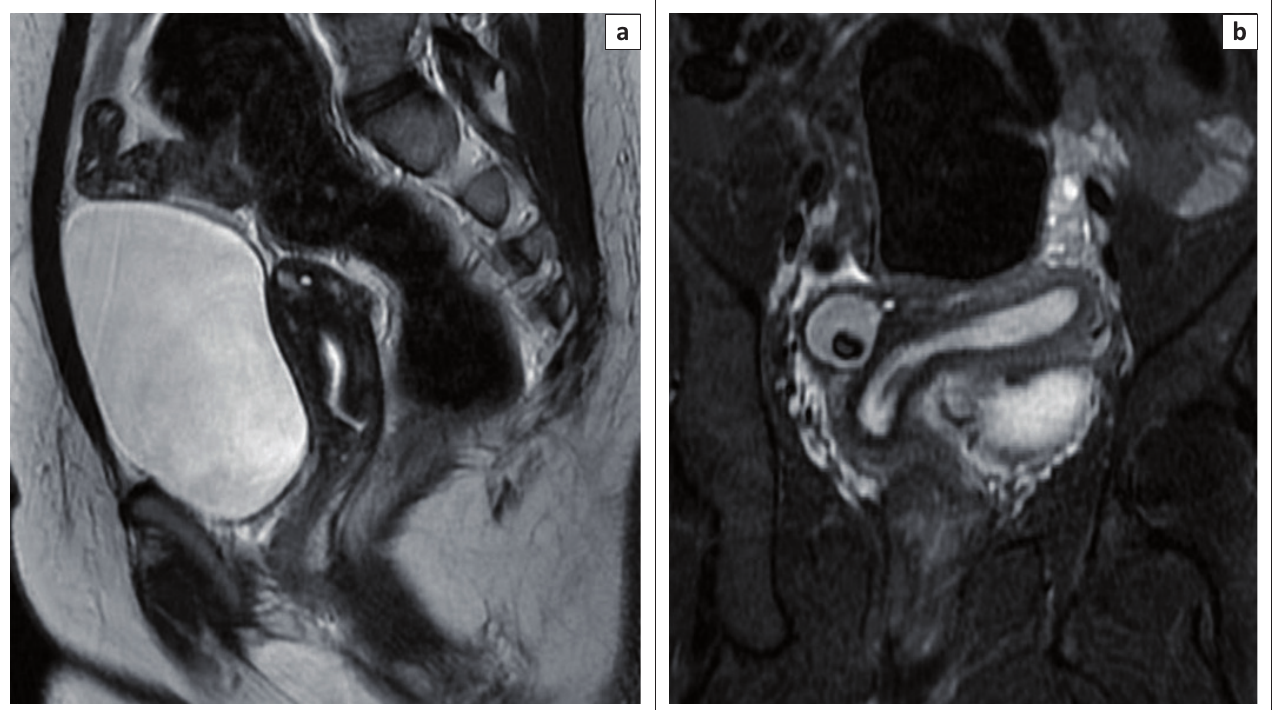
FIGURE 14: Sagittal T2 sequence (a) demonstrates non-extension of the endometrial cavity up to the fundal region. Coronal oblique T2 sequence (b) shows a unicornuate uterus. Banana-shaped endometrial cavity displaced to left side with right ovarian benign teratoma.